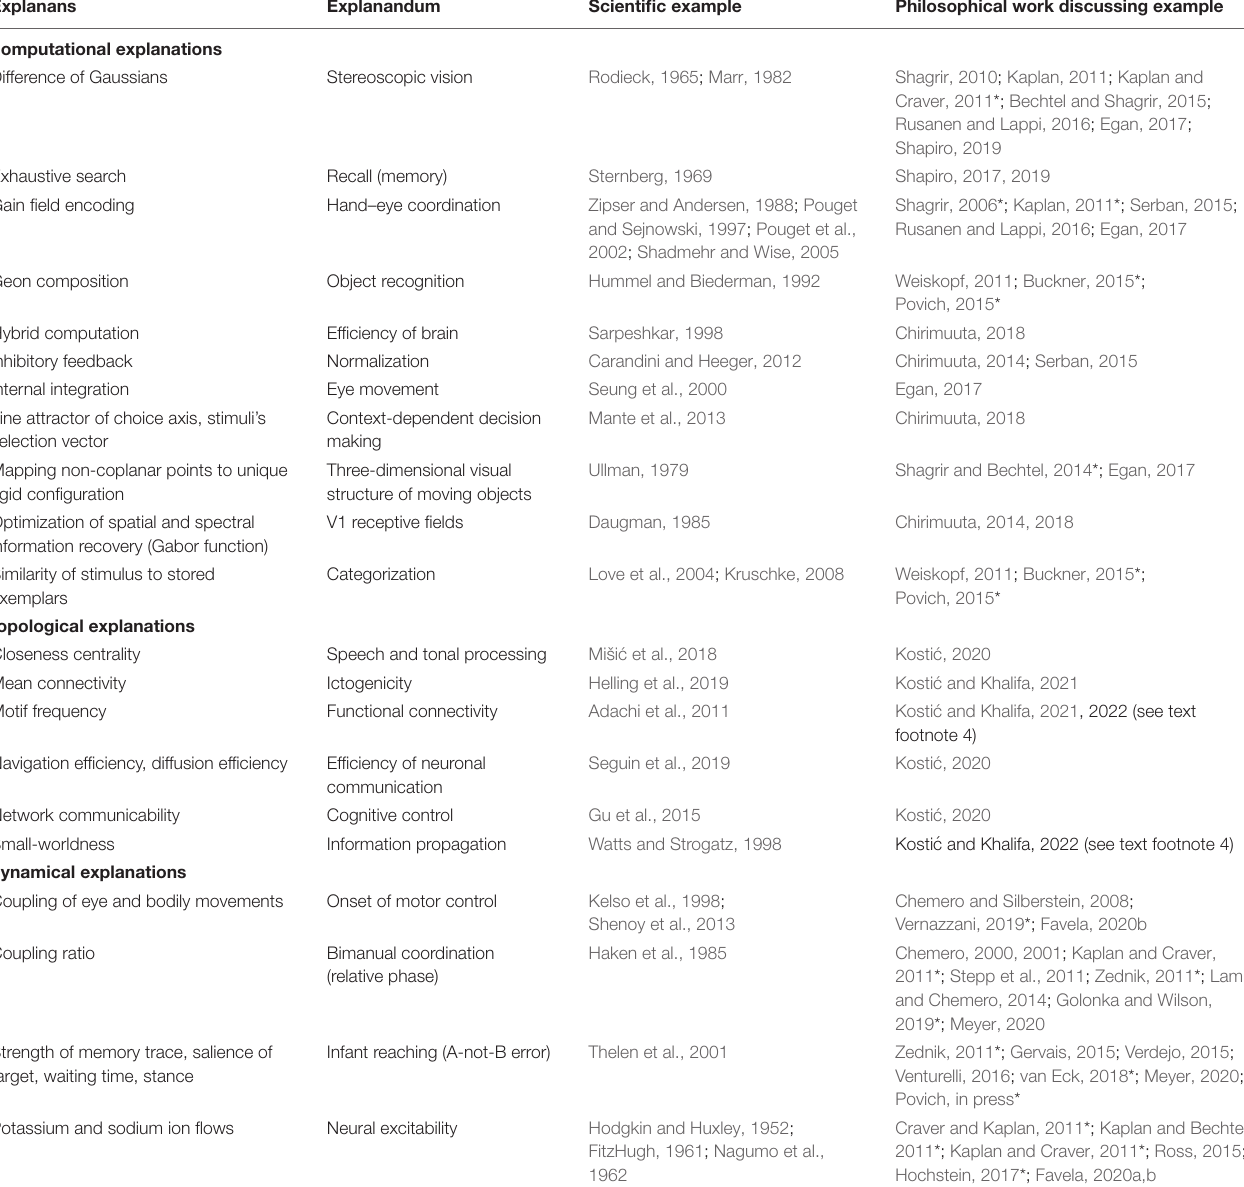
TABLE 2 | Putatively non-mechanistic explanations discussed by